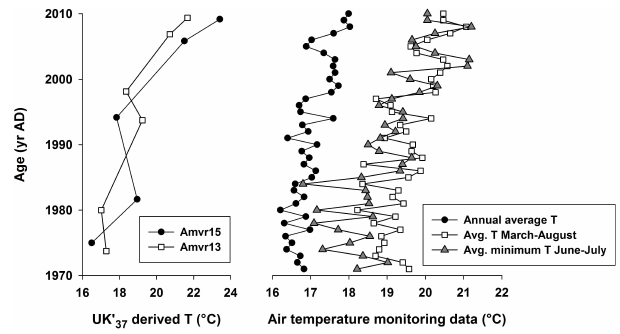
Fig. 8. UK’ 37 index-derived surface water temperatures (left) according to the correlation of M¨uller et al. (1998), UK’ 37 = 0.033 T + 0.069 ( R 2 = 0 . 981) with T = mean annual sea surface temperature, plotted vs. age (yrAD). For com- parison, air temperature data ( ◦ C) between 1970 and 2010 from the meteorological station Preveza (Aktio) were added (data from the Hellenic National Meteorological Service and http://www.weatheronline.co.uk): annual average air temperatures, average air temperatures of March–August, average minimum air temperatures of June–July.